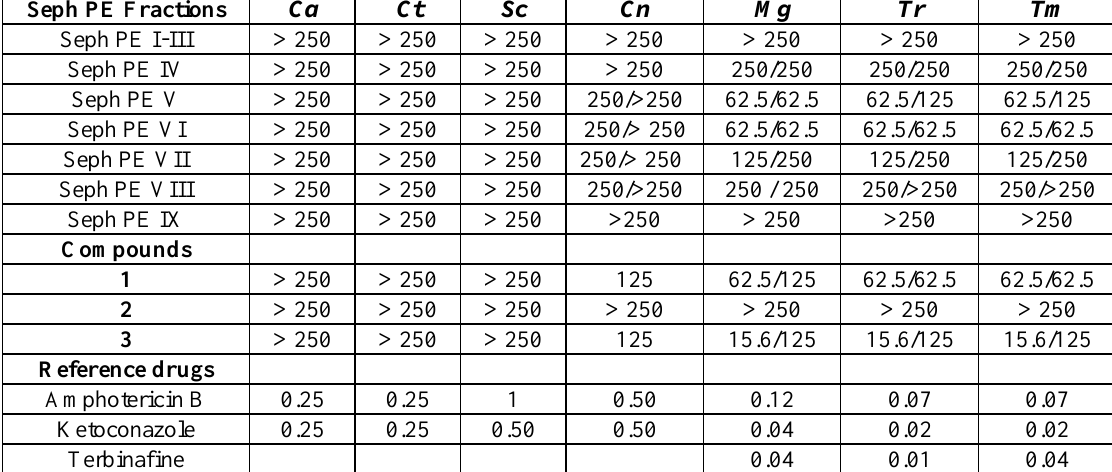
Table 2. In vitro evaluation of the antifungal activity of different fractions resulted from Sephadex percolation of PE extracts and compounds 1-3 from B. darwinii (MIC/MFC values are given in μg/mL).